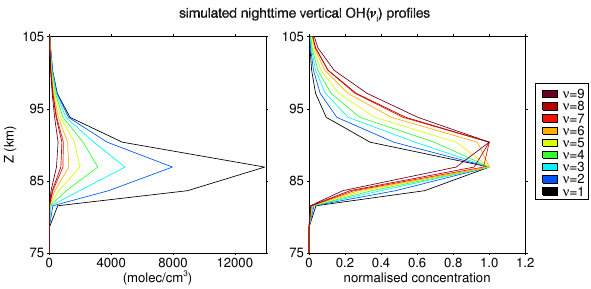
Figure 1. Vertical OH( ν ) profiles calculated from monthly averaged Fig. 1: Vertical OH( ν ) profiles calculated from monthly averaged SD-WACCM4 model output for SD-WACCM4 model output for September 2010, 00:00UTC at the September 2010, 00:00 UTC at the 0 ◦ equatorial latitude. Left panel: absolute number concentra- 0 ◦ equatorial latitude. Left panel: absolute number concentrations. tions. Right panel: normalised OH( ν ) profiles. Right panel: normalised OH( ν )